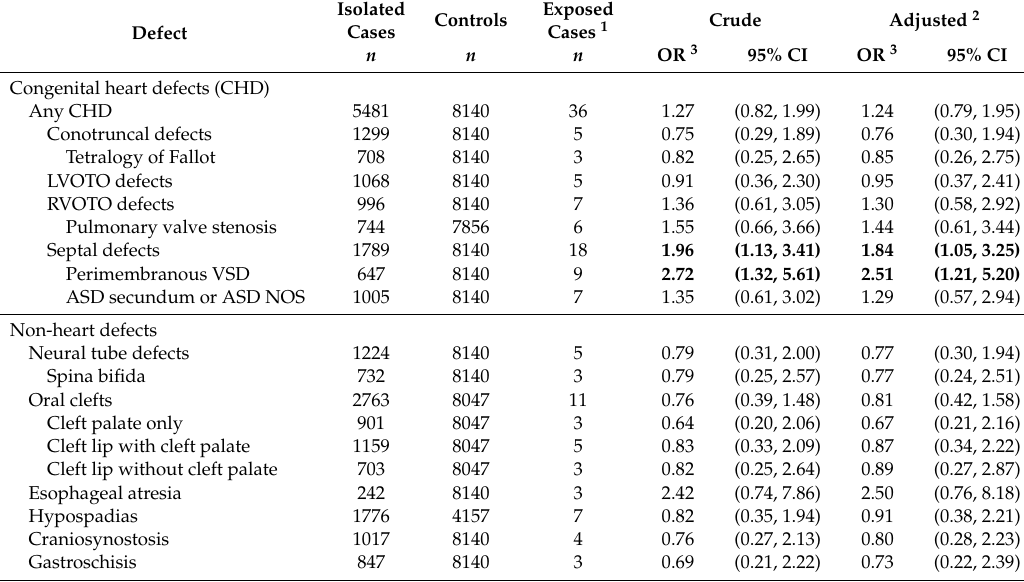
indicates statistically significant associations. OR: Odds ratio; CI: Confidence interval; LVOTO: Left ventricular outflow tract obstruction; RVOTO: Right ventricular outflow tract obstruction; VSD: Ventricular septal defect; ASD: Atrial septal defect; NOS: Not otherwise